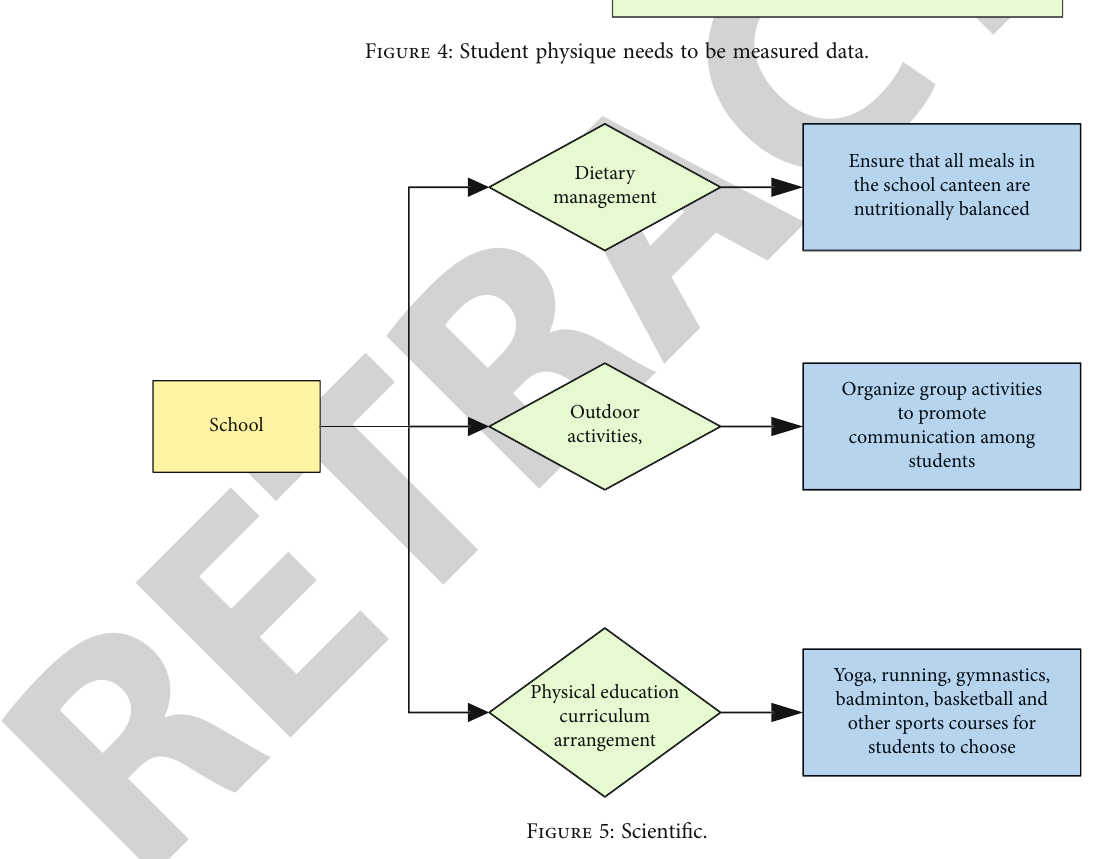
Figure 4: Student physique needs to be measured data.